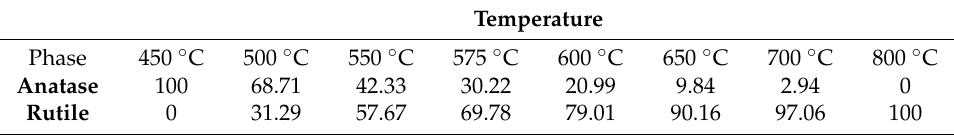
Table 1. Crystallographic composition (%) of TiO 2 nanofibers calcined at different